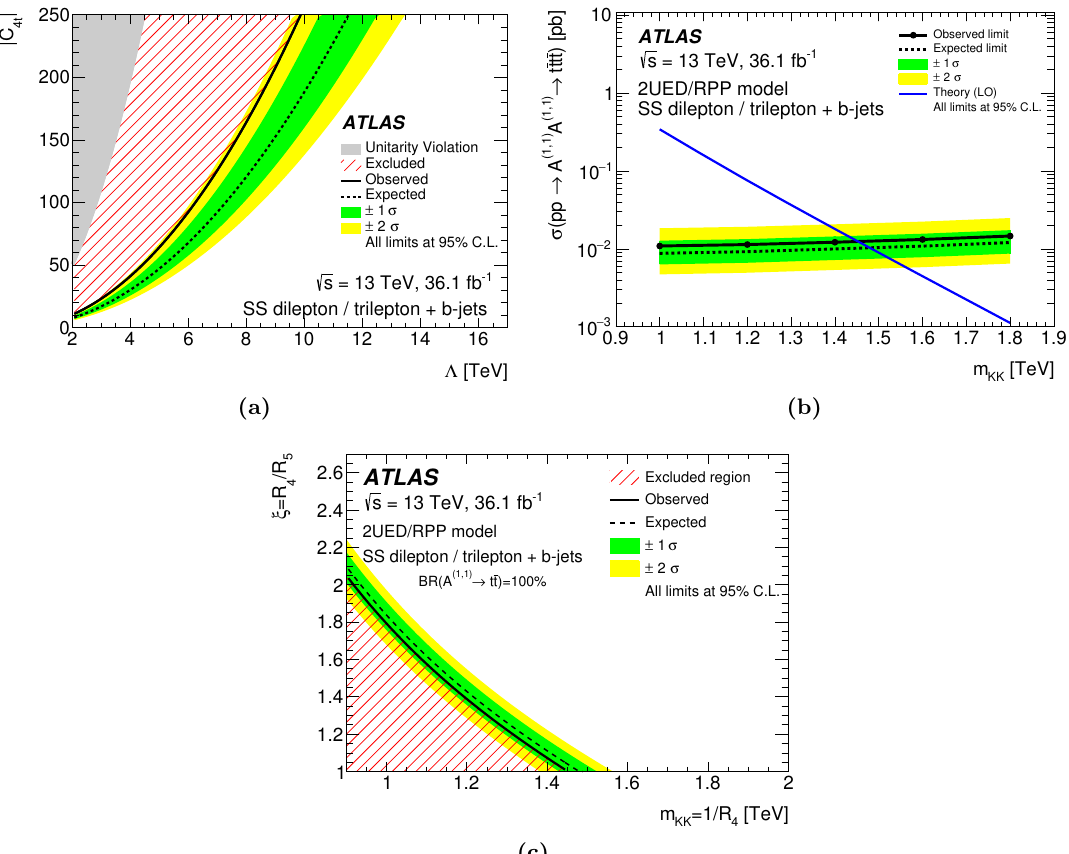
Figure 11 . (a) Constraints in the ( on m KK in the symmetric case. The theory line corresponds to the production of four top quarks by tier (1 ; 1) assuming the branching ratio in the ( m KK = 1 =R 4 ; (cid:24) = R 4 =R 5 ) plane for the 2UED/RPP model. In all plots, the expected 95% CL limits are shown with their